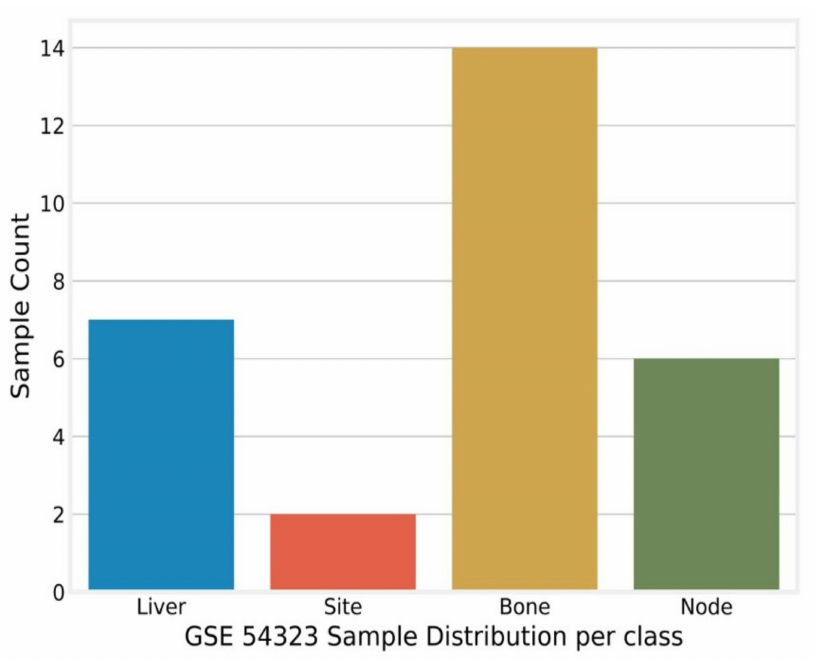
Figure 7. GSE54323 Class imbalance.